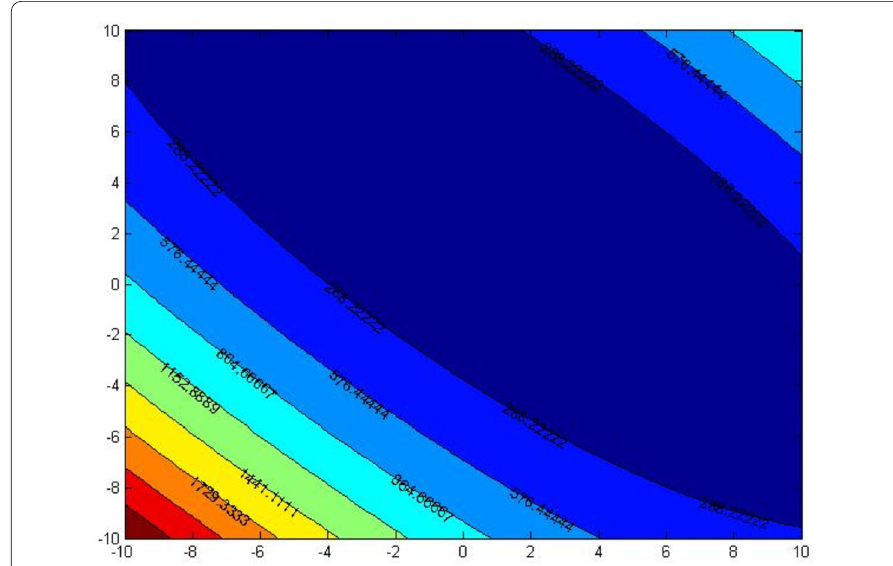
Figure 1 Contour lines for Booth function